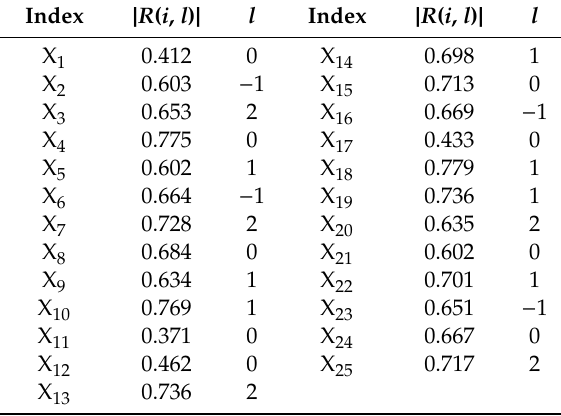
Table 3. Identification and classification of early warning candidate indices in Anhui